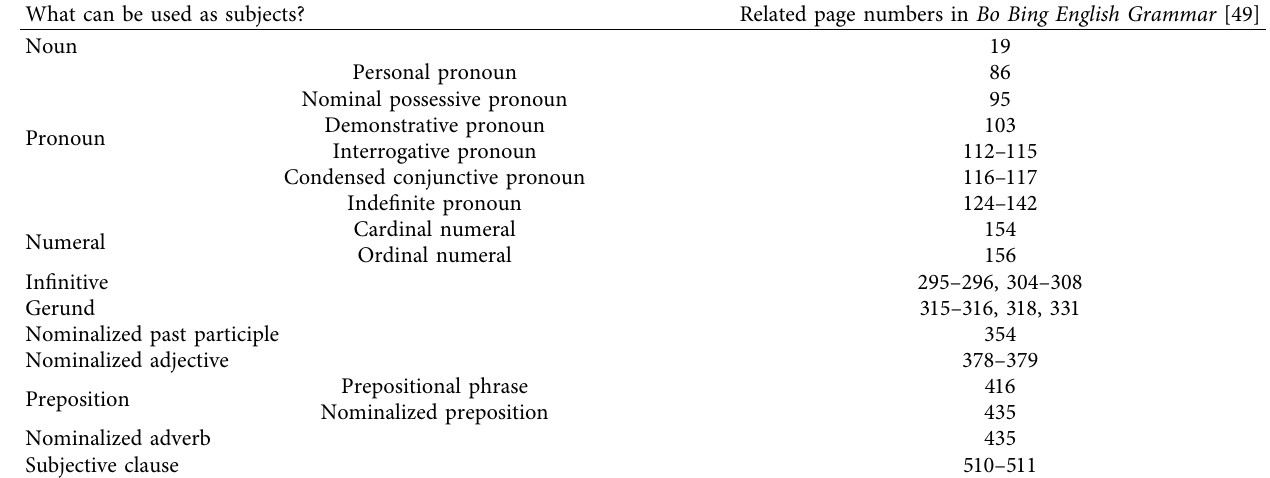
Table 2: What can be used as